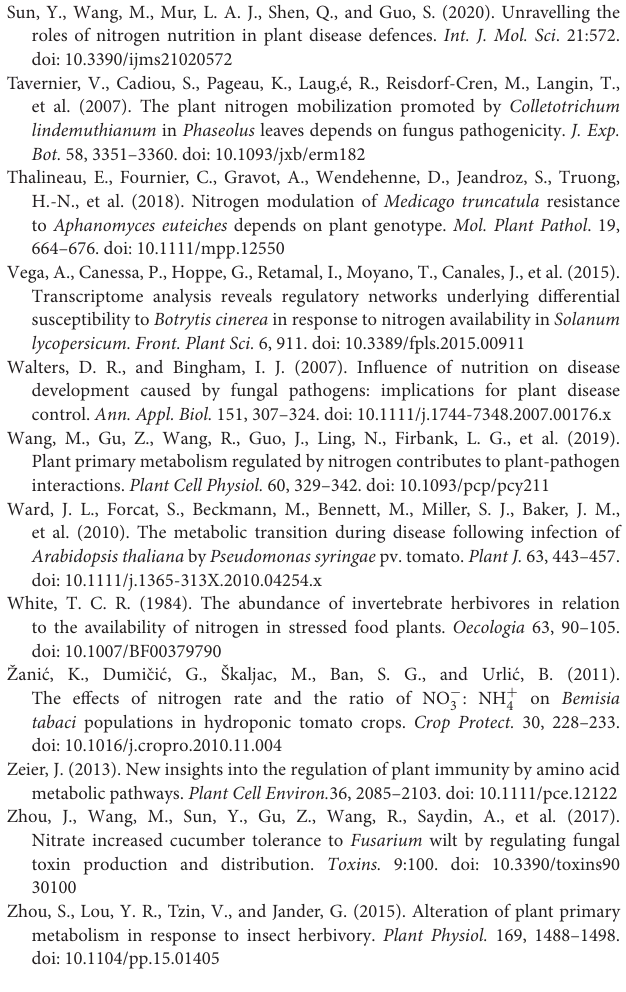
tabaci populations in hydroponic tomato crops. Crop Protect. 30, 228–233. doi: